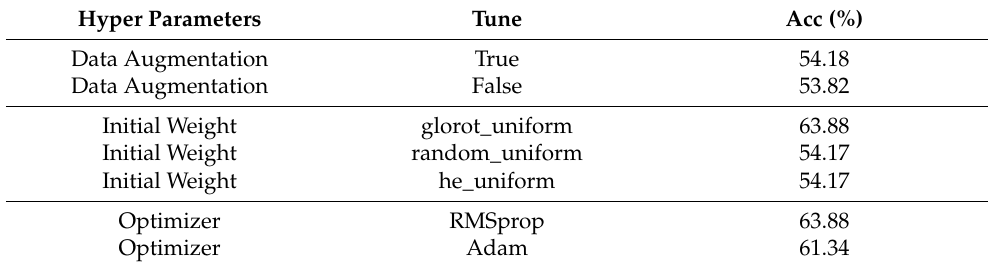
Table 3. Tuning hyper parameters for binary classification on the UCF-Crime dataset.